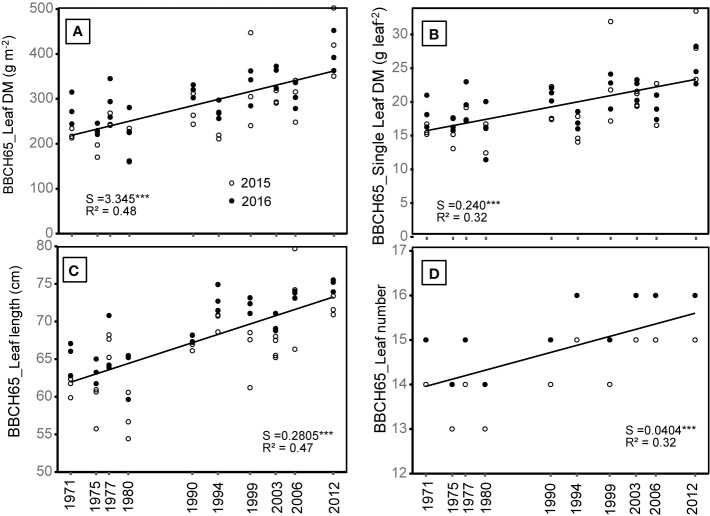

(A) Leaf DM (summed over the measurement levels), (B) average single leaf DM, (C) average Leaf length, and (D) average leaf number at flowering from 10 different hybrids, which were released in the period between 1971 and 2012 and either grown in 2015 or 2016. S = slope of the regression. The regression indicates differences among hybrids across the year of registration. All slopes were tested to be significantly different from zero. Significance levels are: ***p < 0.001. Values are averages from three plants per plot with three blocks.